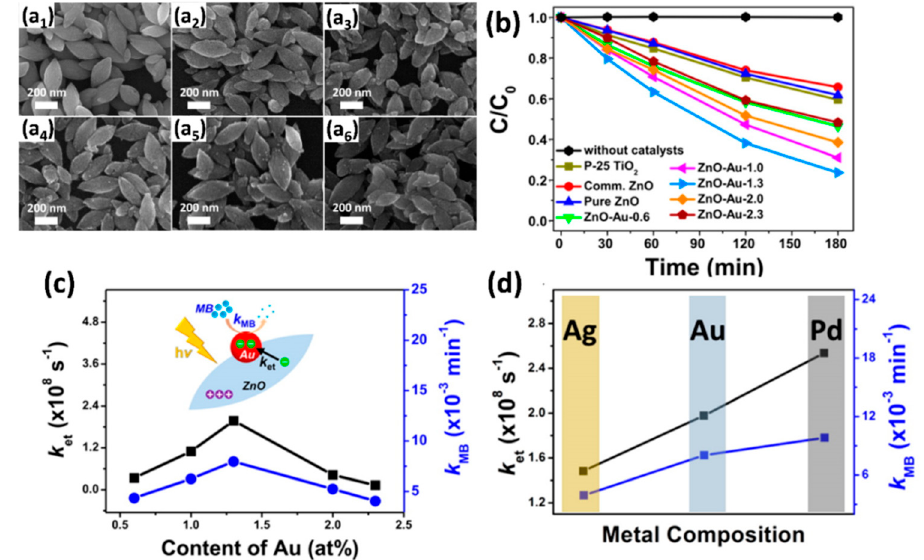
Figure 12. SEM observations for ( a 1 ) pure ZnO and ( a 2 –a 6 ) ZnO–Au nanocrystals with increasing Au content from 0.1 at.% to 2.3 at.%. ( b ) Photodegradation of MB on relevant photocatalysts under UV irradiation. ( c ) Correlations of k et and k MB for ZnO–Au with different Au content and for ( d ) ZnO–metal (Ag, Au, Pd) with different metal content (reproduced with permission from [80]. Copyright American Chemical Society, 2016.).